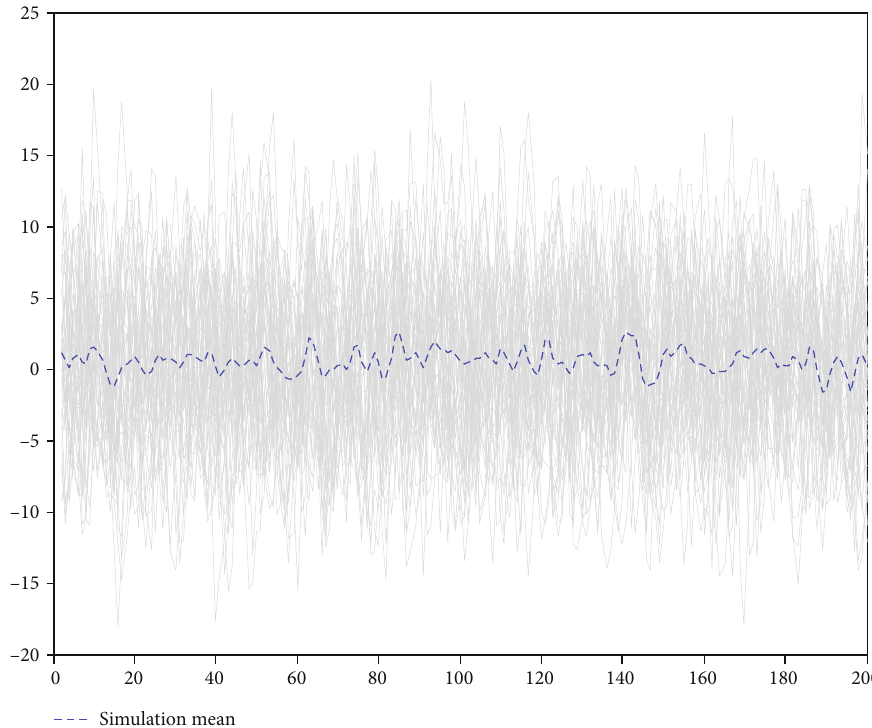
Figure 6: Di ff erence between the smaller and larger PV farms using ensemble model.